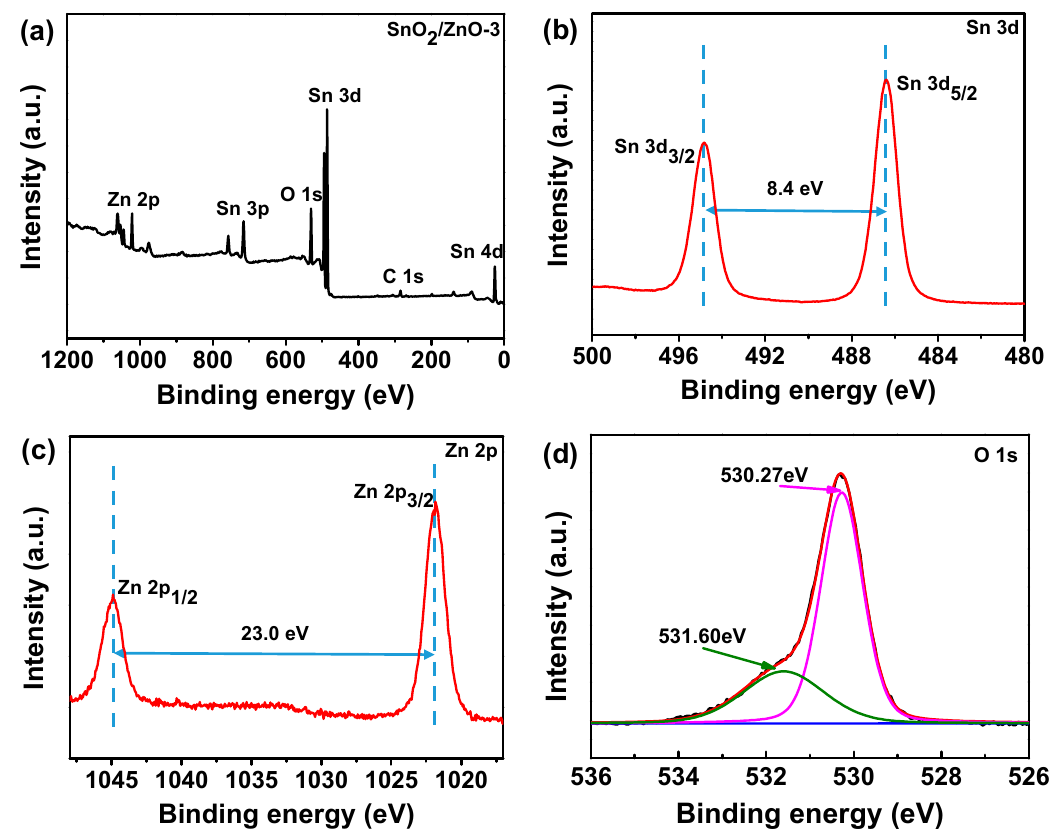
Figure 4. ( a ) Survey, ( b ) Sn 3d, ( c ) Zn 2p, ( d ) O 1s XPS spectra of SnO 2 /ZnO-3 composite nanofibers. Table 1. The content of Sn, Zn, O, and C elements, and the specific surface area of SnO 2 , SnO 2 /ZnO-1, SnO 2 /ZnO-2, and SnO 2 /ZnO-3. Samples Sn (at.%) Zn (at.%) O (at.%) C (at.%)